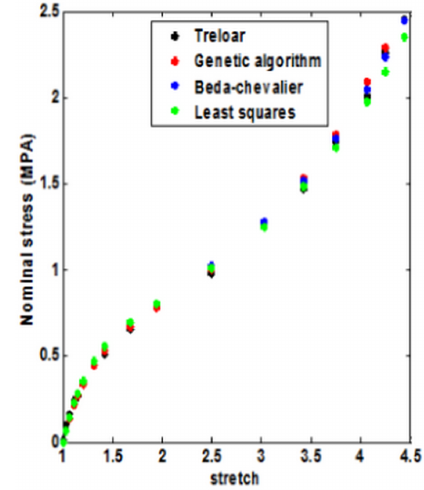
Figure 3: Biaxial